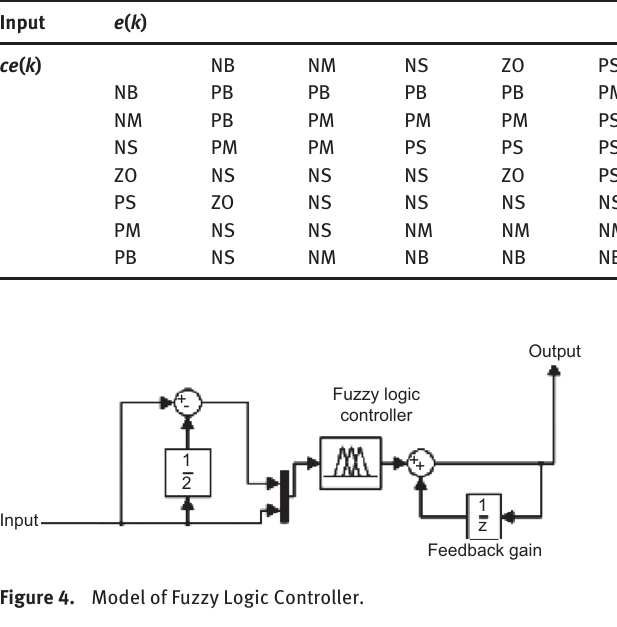
Figure 4. Model of Fuzzy Logic